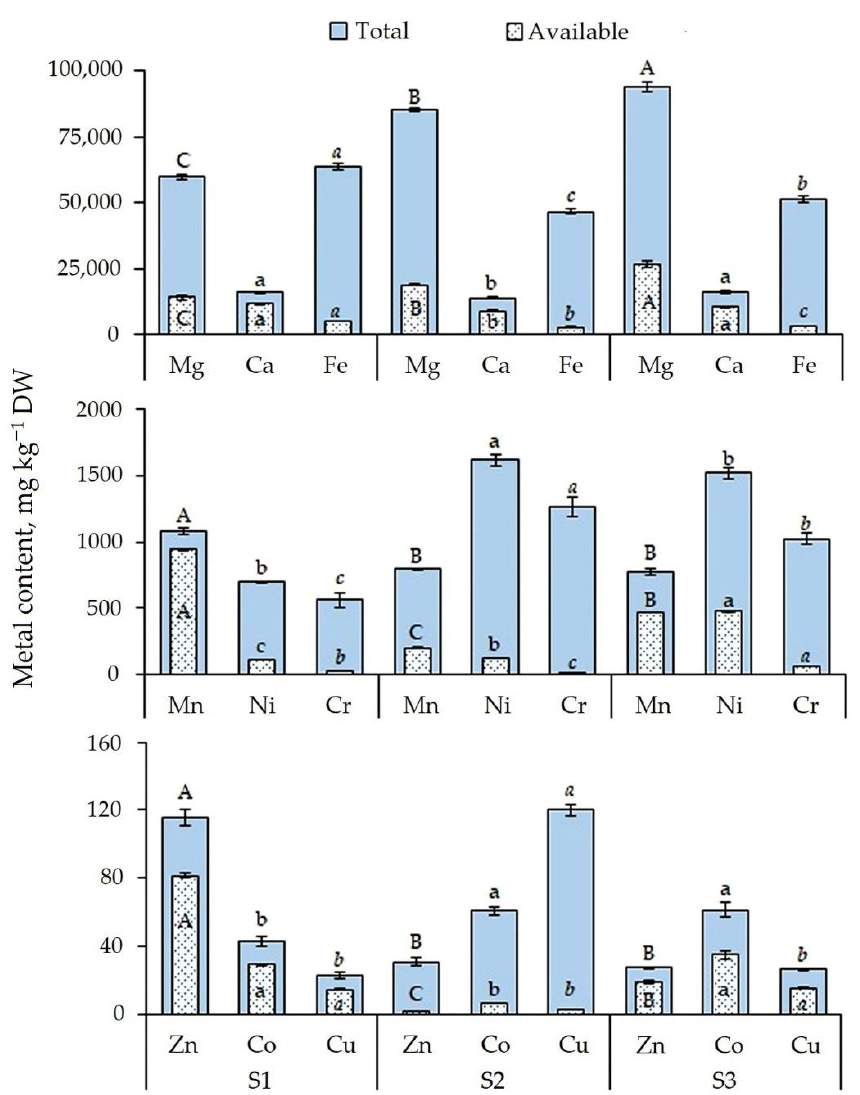
Figure 3. Total and available metal content in soil substrates from studied sites. Data is presented as Means ± SE ( n = 4). Different alphabetical letters indicate a significant difference between the studied sites at p < 0.05.